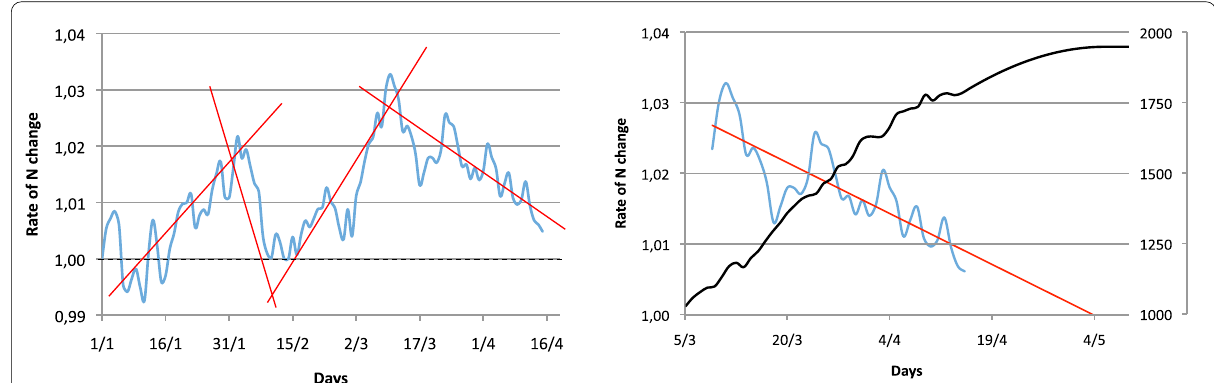
Fig. 3 The left panel reports the same data as the right panel of Fig. 2, with identifications of significant slopes (red lines). When the curve reaches 1, the epidemic decreases ( R t < 1). On the right panel, we zoomed in on the last part of the evolution with its regression line and extrapolation crossing the x-axis on May 4. On this same figure, the corresponding number of patients can be derived from the regression curve and superimposed (black curve). The 95% confidence interval of both the regression line and the derived number of patients can be easily obtained from traditional regression lines models (not reported here for